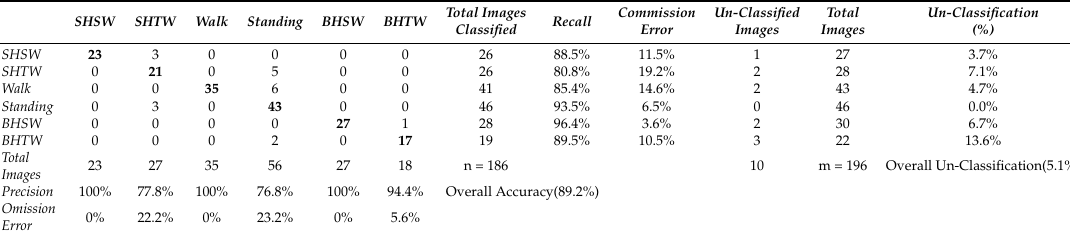
Table 6. Classification matrix for Ido images.